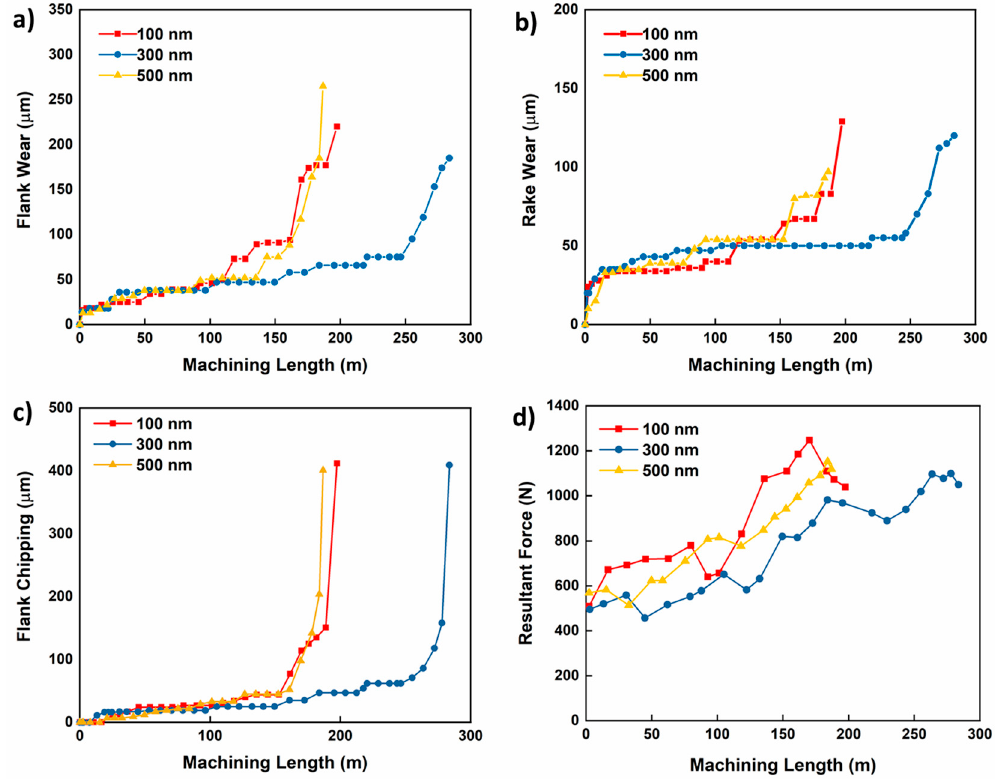
Figure 12. Tool-life data of the studied coatings vs. machining length (m): ( a ) flank wear; ( b ) rake wear; ( c ) chipping intensity; ( d ) resultant cutting forces .